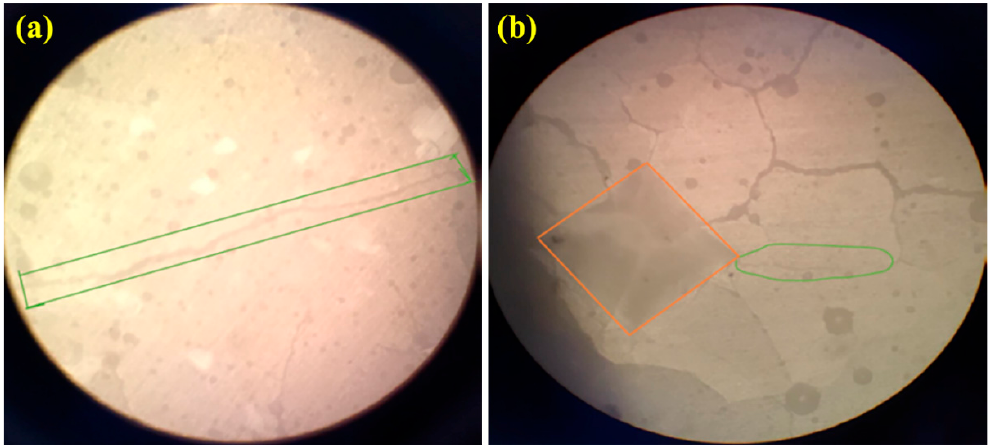
Figure 10. Optical microscopy images of the hardness effect under 200 N and the cracks created at the hardness outline of the: ( a ) glass ionomer cement (GIC), and ( b ) glass ionomer cement (GIC) 4 wt% diopside (DIO) composite.